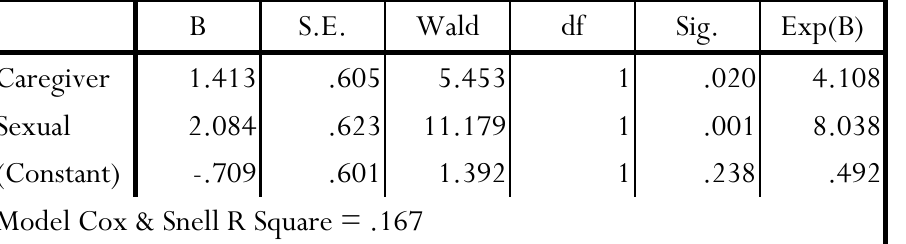
Table 10: Logistic Regression of Presence of Victimization on Presence of Substance Use B S.E. Wald df Sig. Exp(B) Caregiver 1.413 .605 5.453 1 .020 4.108 Sexual 2.084 .623 11.179 1 .001 8.038 (Constant) -.709 .601 1.392 1 .238 .492 Model Cox & Snell R Square =